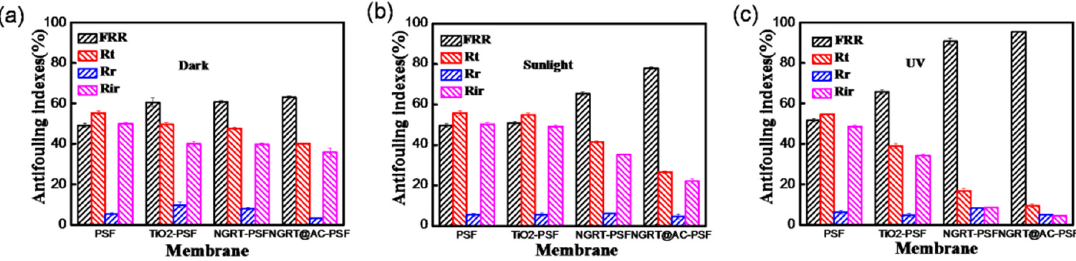
Membranes 2019 , 9 , 16 11 of 13 Figure 12. Flux values at different steps (pure water, MO solution, water cleaning) under ( a ) dark, ( b ) sunlight and ( c ) UV conditions. To deeply understand the tested membranes antifouling performance, values were obtained by calculating the flux of the membrane before and after contamination by MO solution. The antifouling indices of all the membranes under dark/sunlight/UV irradiation are shown in Figure 13. It is widely recognized that the higher the flux recovery ratio the membrane has better antifouling performance. The flux recovery ratio (FRR) of the PSF membranes under UV irradiation (shown in Figure 13c) was as low as 51.6%, whereas the other membranes exhibited an overall value of 65.8%. In particular, for the NGRT@AC-PSF membranes, the FRR values reached to 95.5% when the